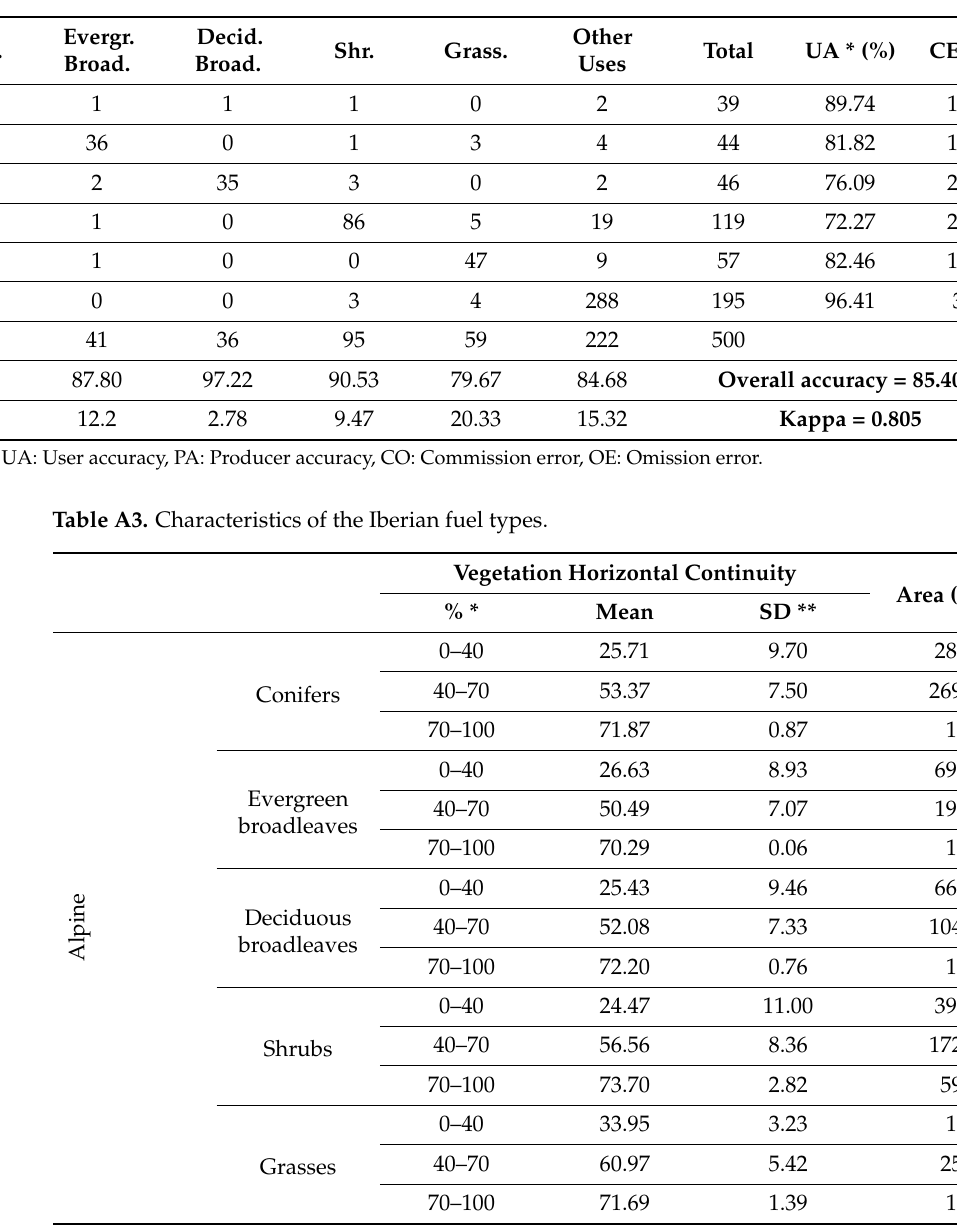
Table A2. Confusion matrix for the vegetation map.